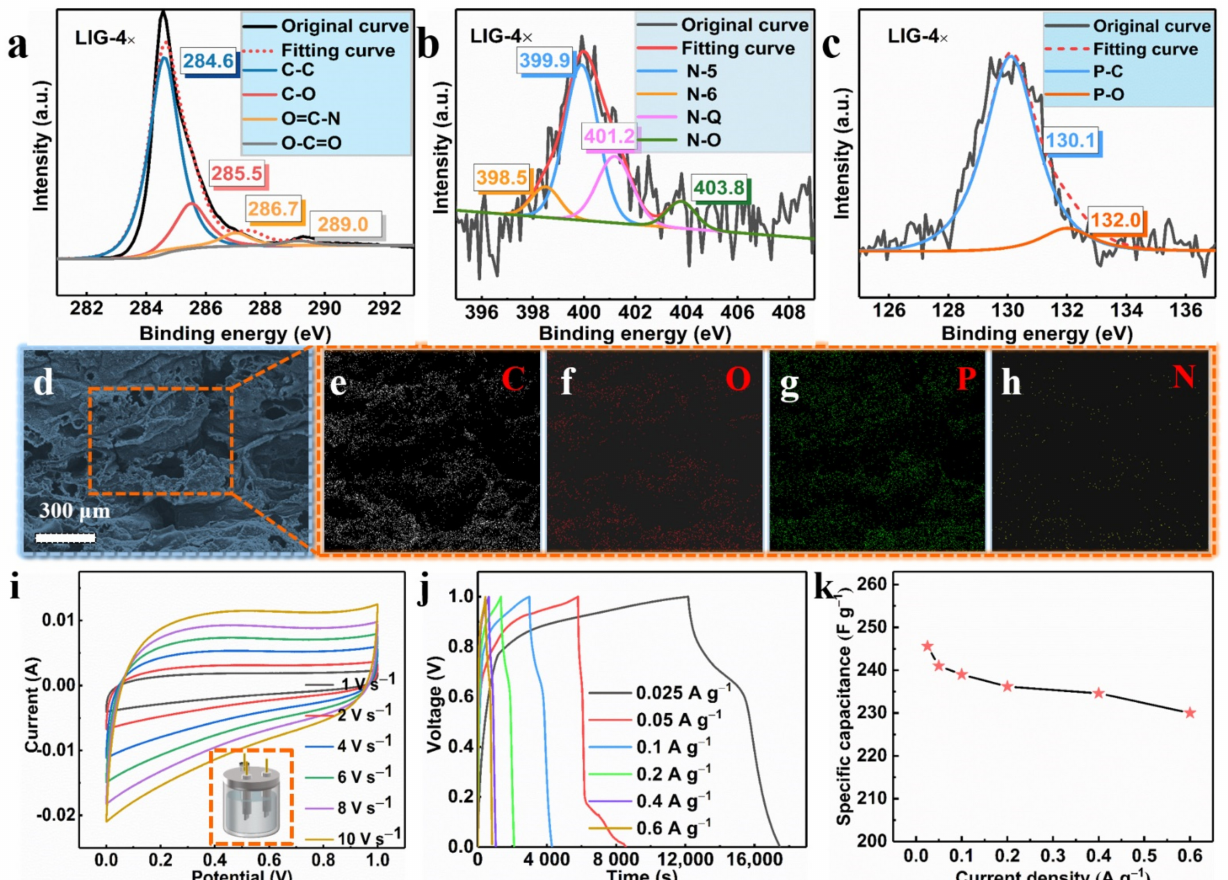
Figure 5. ( a ) C 1s XPS spectrum of the LIG obtained using laser scribing (LIG 4 × ). ( b ) N 1s XPS spectrum of the LIG generated by four laser passes (LIG 4 × ). ( c ) P 2p XPS spectrum of the LIG prepared using four laser passes (LIG 4 × ). ( d ) SEM image of the LIG formed on the surface of APP/EP. The corresponding EDX results for C ( e ), O ( f ), P ( g ), and N ( h ). ( i ) Cyclic voltammetry (CV) curves of the LIG/EP electrode at scan rates ranging from 1 to 10 V · s − 1 . ( j ) Galvanostatic charge–discharge (GCD) curves of the LIG-EP electrode at various current densities ranging from 0.025 to 0.6 A · g − 1 . ( k ) The specific capacitance (Csc) of the LIG/EP in the current density range from 0.025 to 0.6 A · g − 1